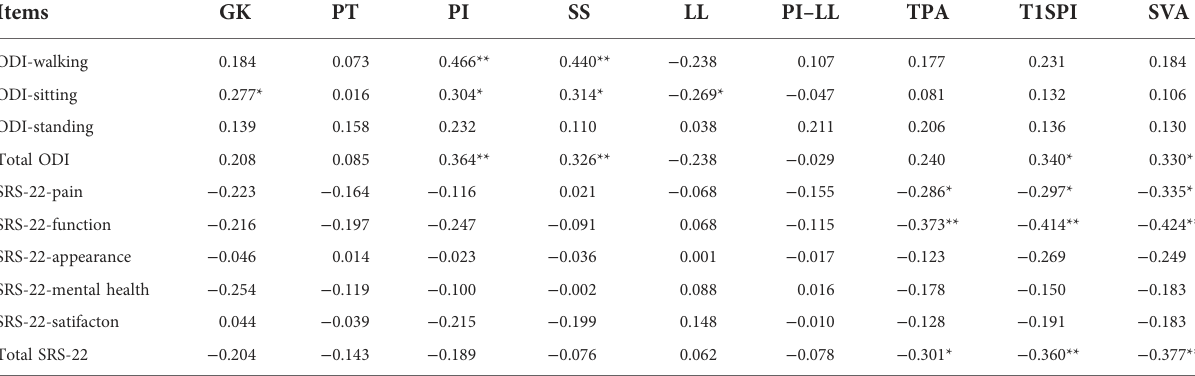
TABLE 3 Correlation between postoperative immediate parameters and fi nal follow-up Oswestry Disability Index and Scoliosis Research Society-22 scores.